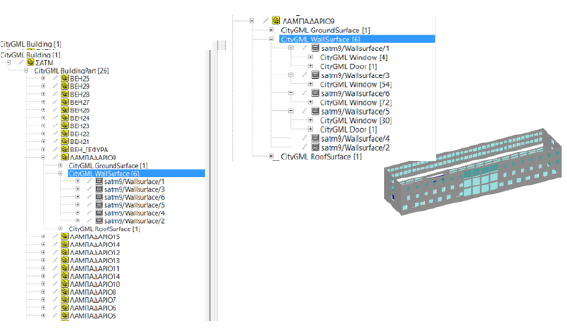
Figure 5. LoD3 building of NTUA campus with detailed semantics